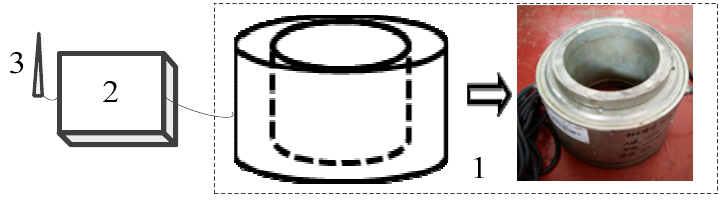
Figure 1. The sensing system in References [24–28]. ( 1 )-The vibrating wire sensor; ( 2 )-The signal processing system; ( 3 )-The wirelessly transmitting system.